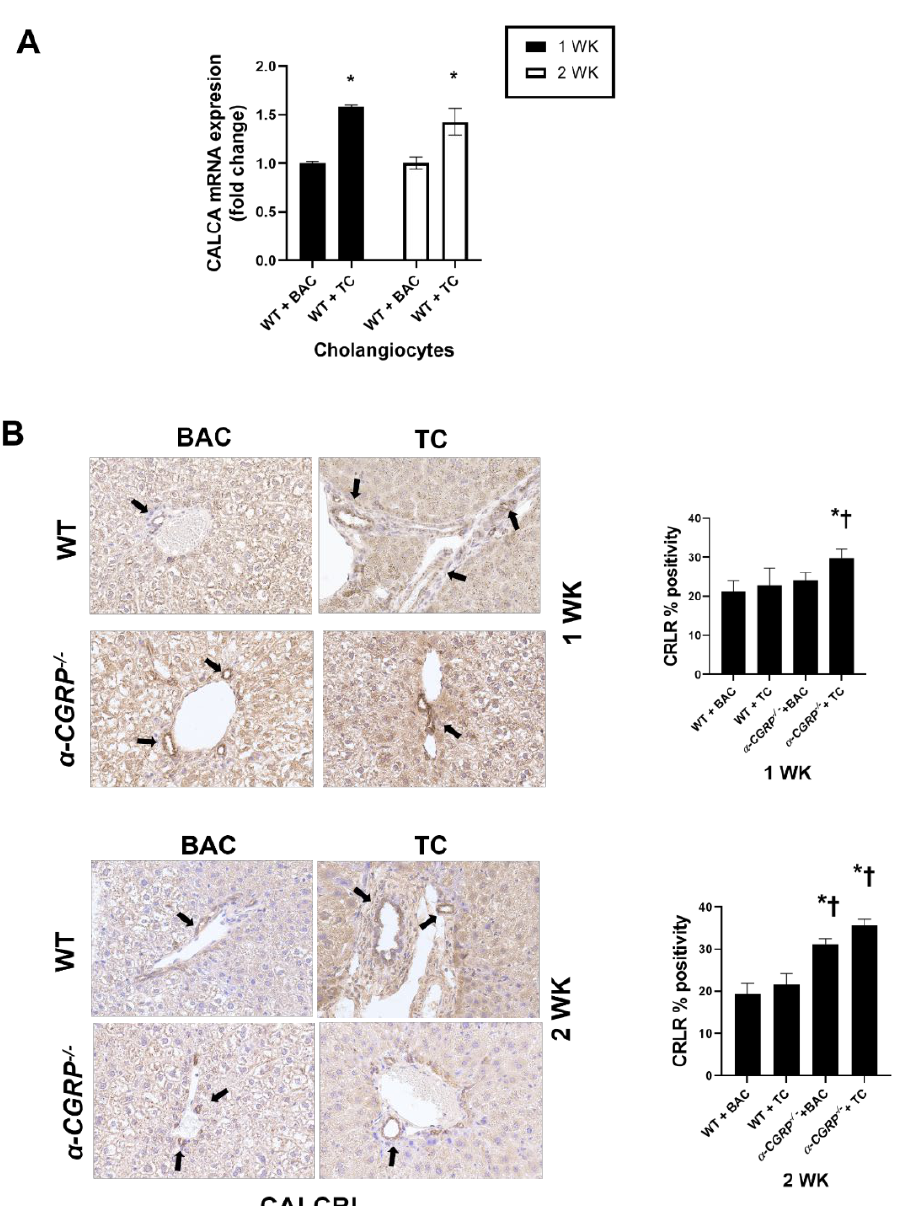
Figure 1. CALCA gene and CALCRL expression. ( A ) TC-fed WT mice showed elevated CALCA expression (gene for α -CGRP) compared to BAC-fed WT mice. Evaluations from three cumulative preparations of cholangiocytes from five mice per group. * < p value vs. WT + BAC. ( B ) CALCRL ( α -CGRP receptor component) staining by immunohistochemistry in liver sections. Original magnification 40 × ; black arrow indicates bile ducts. Data for IHC quantification are mean ± SEM of scanning slides from n = 6 different animals per groups. * < p value vs. WT + BAC; † < p value vs. WT + TC.